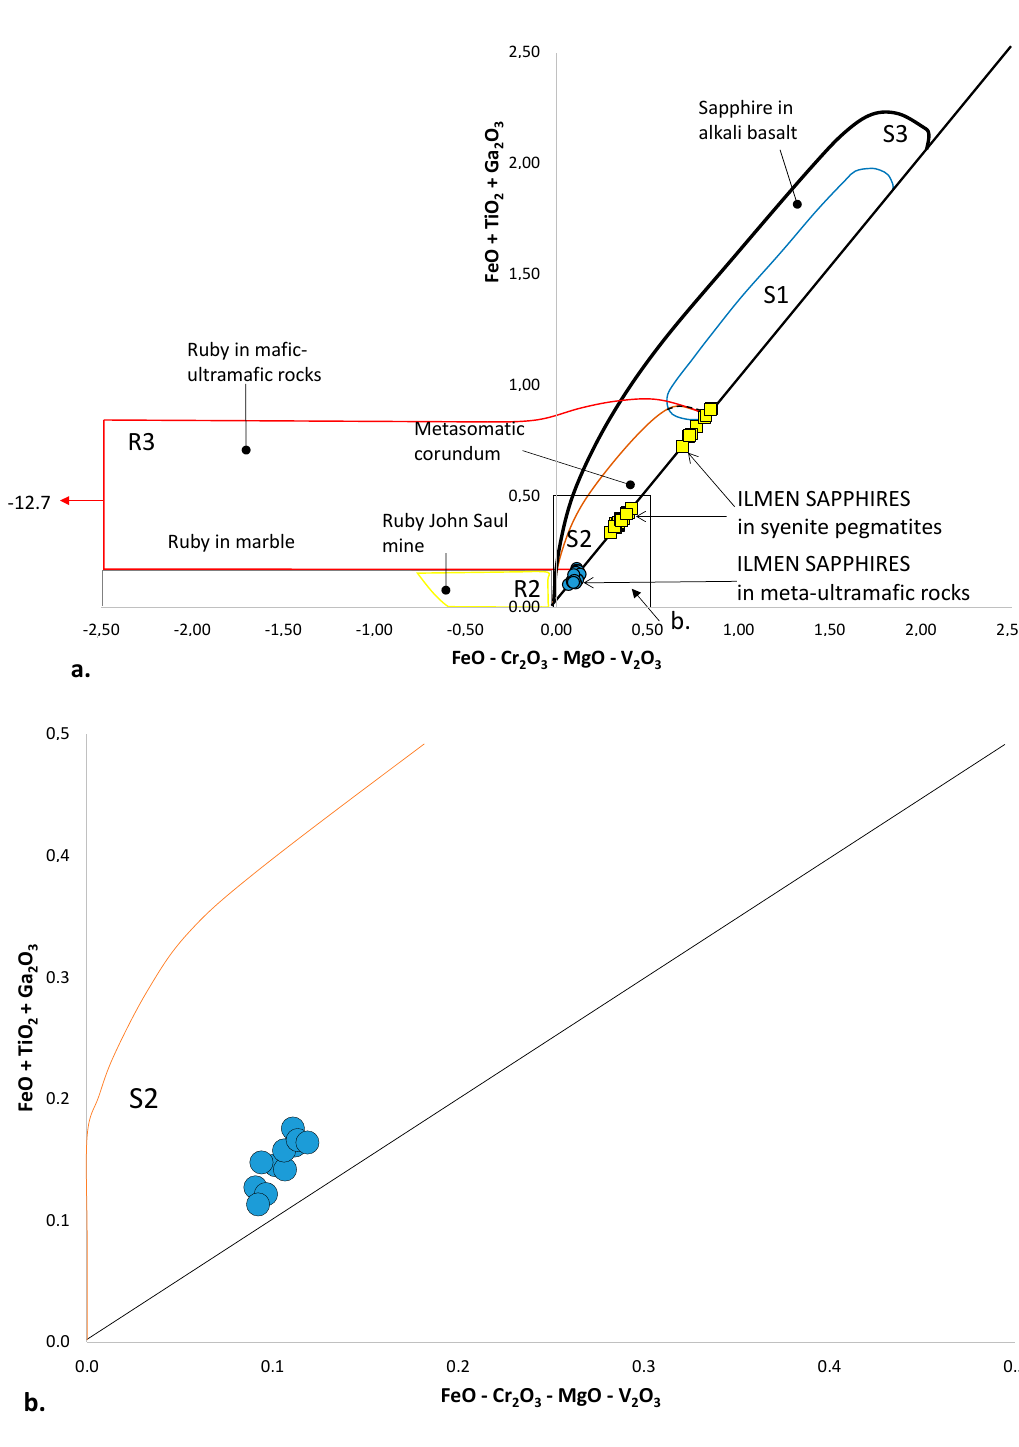
Figure 8. ( a ) A plot of Ilmen sapphires within meta-ultramafic rocks (bold blue circles) in a FeO–Cr 2 O 3 –MgO–V 2 O 3 versus FeO–TiO 2 –Ga 2 O 3 diagram (in wt. %) used for the geological classification of corundum deposits are modified after [18]. The main fields defined for the different types of gem corundum deposit are: John Saul Ruby Mine (Kenya) type (R2) is for ruby; for sapphire, syenitic rocks (S1); metasomatites (S2); xenocrysts in alkali basalt and lamprophyre (S3). The domains of ruby in mafic–ultramafic rocks and S2 are overlapping. Values of Ilmen sapphires within syenite pegmatites are after [6]. ( b ) Focus on the distribution of Ilmen sapphires within metasomatites (S2) of the plot A).